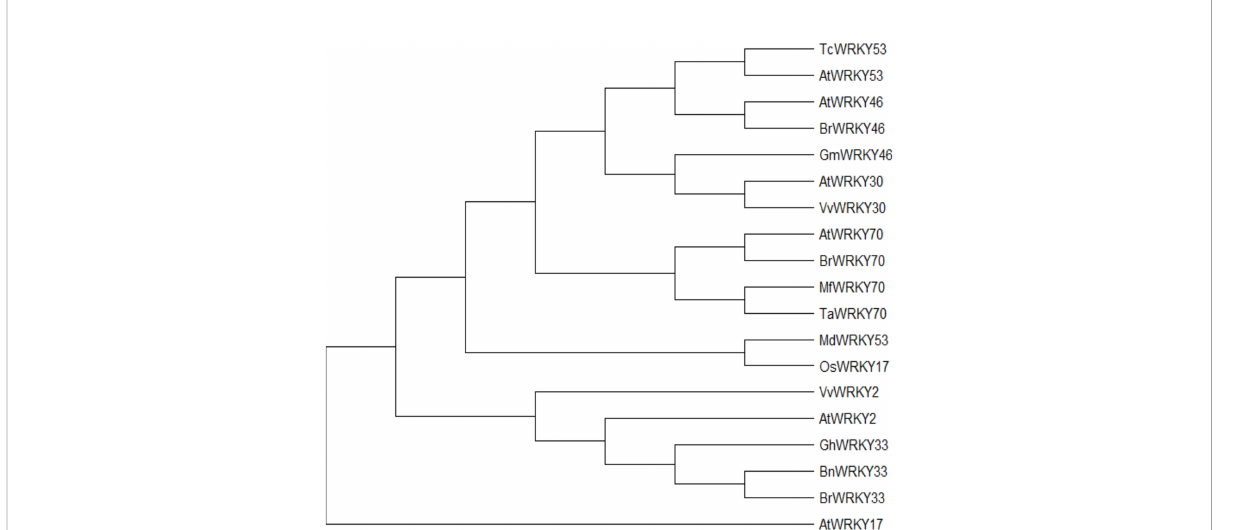
FIGURE 1 Neighbor-joining phylogeny of WRKY-related protein. MEGA X reconstructed the neighbor-joining phylogeny with 1000 bootstrap replicates and used maximum composite